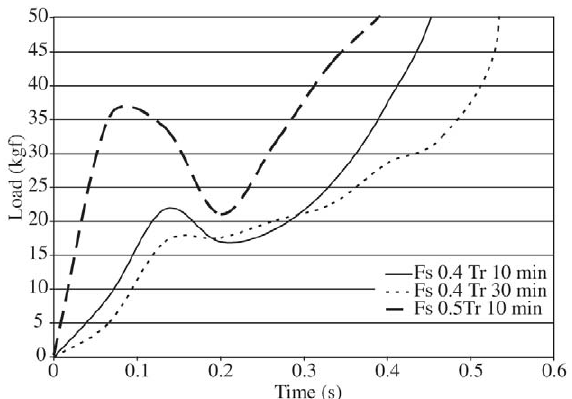
Figure 6. Curves of force against deformation time for two differ- ent solid fractions (0.4 and 0.5) and two different soaking times at 590 and 580 °C. Cups were produced employing a TMT A356 al- loy.